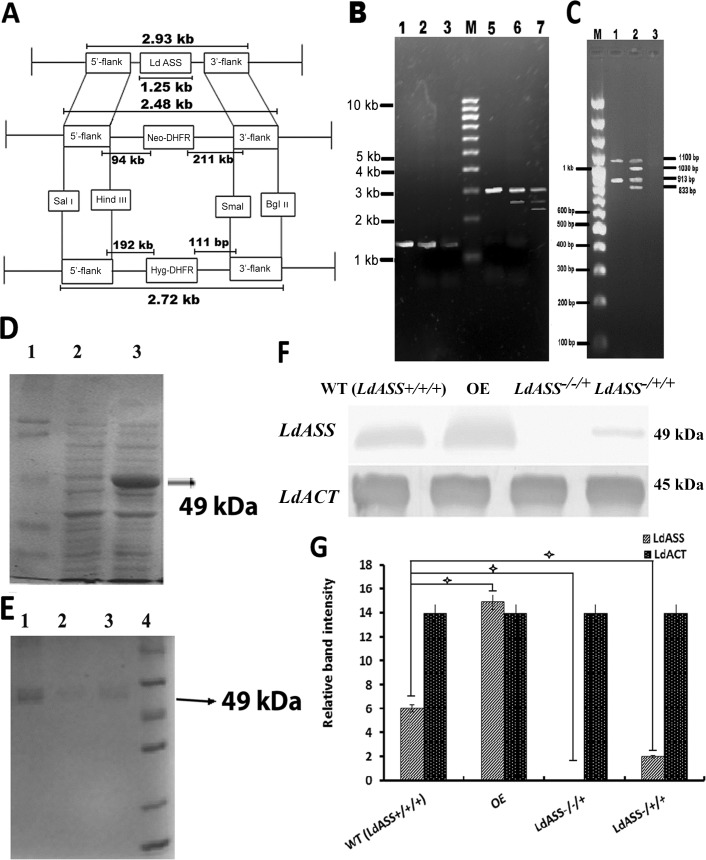
Targeted gene replacement of LdASS alleles, expression and purification of recombinant LdASS protein.A) Schematic representation of the LdASS locus and the plasmid constructs used for gene replacement experiments is illustrated. B) PCR analysis of the -amplified products of LdASS gene. Lanes: PCR with genomic DNA from WT, LdASS-/+/+ mutant and LdASS-/-/+ mutant cell lines to amplify full length (1250 bp) LdASS gene (lanes 1–3), molecular weight marker (M), PCR with genomic DNA from WT, LdASS-/+/+ mutant and LdASS-/-/+ mutant using F7/R8 primer pairs (S1 Table). External forward (F7) and reverse (R8) primers were designed from 902 bp upstream of the LdASS gene and 775 bp downstream of the stop codon of the gene, respectively. The expected size of LdASS, HYG and NEO gene PCR products were 2.93, 2.72 and 2.48 kb, respectively (lanes 5–7). C) PCR amplified products using primers (F9/R9, F10/R10, F11/R11 and F12/R12) (S1 Table) designed from the upstream and downstream sequences of 5’-flanking region and 3’flanking region respectively (outside of the gene deletion construct) and internal region of the two genes used as selectable marker i.e. hygromycin phosphotransferase (HPT for HYG resistance) present in pX-63-HYG and neomycin phosphotransferase (NPT for neomycin resistance) present in pX-63-NEO plasmid vectors respectively. The PCR image showed the presence of two bands correspond to 1100 bp and 913 bp (5’flank-LdASS-pX-63-HYG-3’flank-LdASS construct) in LdASS-/+/+ cell line (lane 1) and four bands correspond to 1100 bp and 913 bp (5’flank-LdASS-pX-63-HYG-3’flank-LdASS construct); 1030 bp and 833 bp (5’flank-LdASS-pX-63-NEO-3’flank-LdASS construct) in LdASS-/-/+ cell line (lane 2). In WT cell line no bands were detected (lane 3). Lane M containing the molecular weight marker loaded. D) SDS-PAGE analysis for the expression of recombinant LdASS protein. Lane 1, molecular weight marker; lane 2, -IPTG; lane 3, + IPTG (IPTG induction for 4 hours). E) SDS-PAGE analysis of purified recombinant LdASS protein. Lanes 1–3, purified protein; lane 4, molecular weight marker. F) Western blot shows the relative expression levels of LdASS and actin in the various wild type and mutant L. donovani promastigote cell lines. G) Bar diagram showing expression level of LdASS protein in different cell lines. Each measurement was performed in triplicate and data are expressed as the mean. Vertical lines on top of the bars represent s.e. values and star symbol above the vertical lines denotes significant changes with P<0.005.